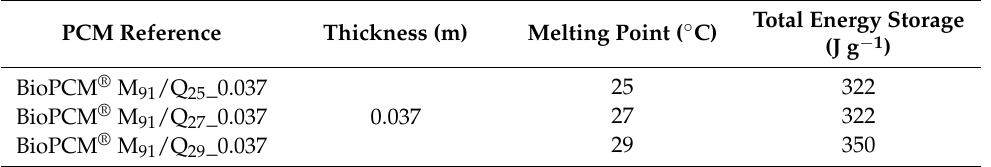
Table 5. Used phase-change material (PCM): main